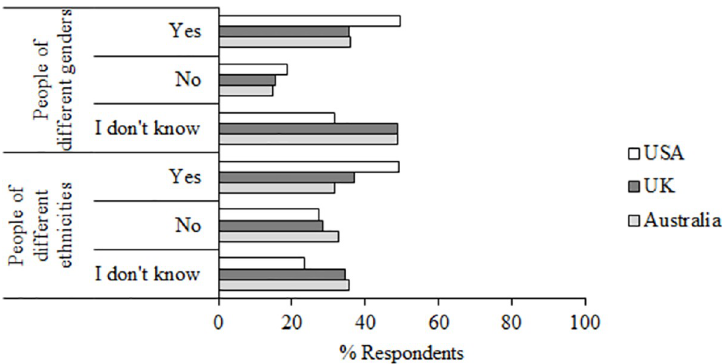
Fig 13. Questions 20–21 data. Percent responses to questions 20–21 “Do you think this technology is equally accurate with people of different genders/ethnicities”.